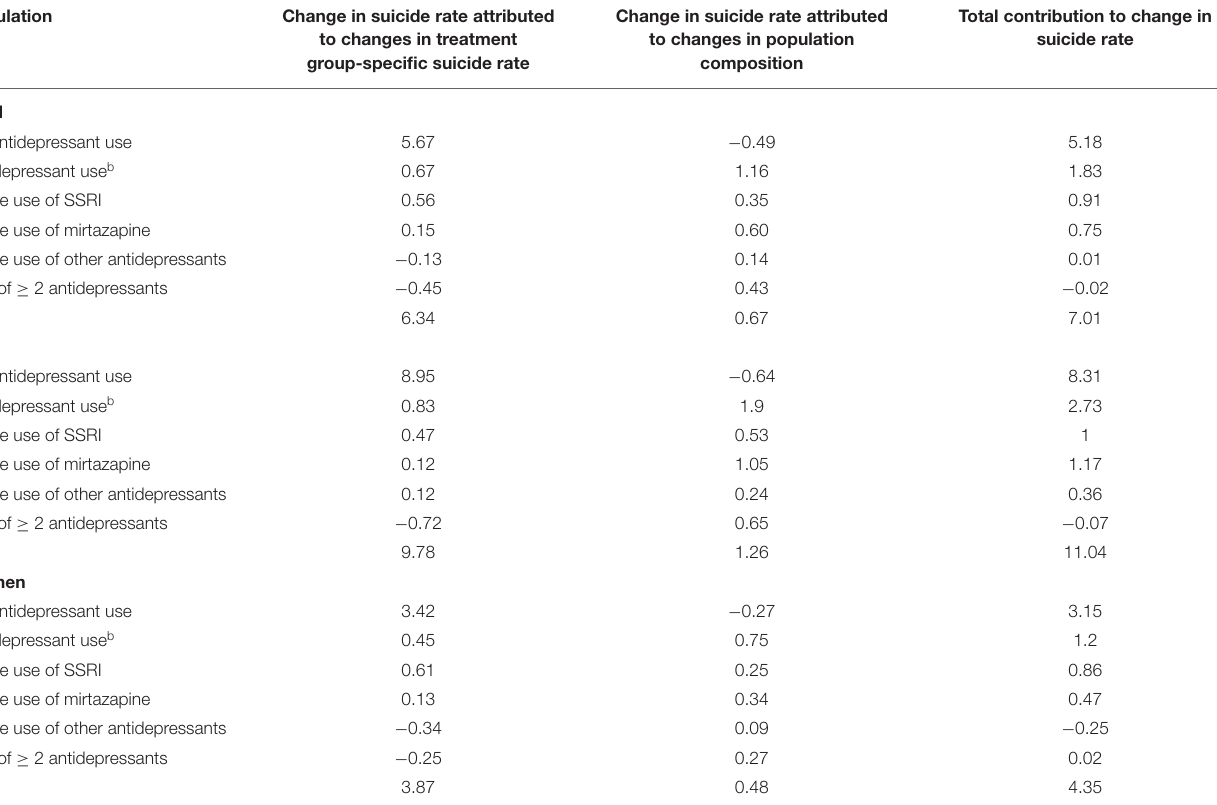
TABLE 4 | Decomposition of the change over time in the suicide rate per 100,000 by antidepressant (AD) treatment group among persons aged 75 and above residing in Sweden a from 2007–2008 to 2013–2014. Population Change in suicide rate attributed Change in suicide rate attributed Total contribution to change in to changes in treatment to changes in population suicide group-specific suicide rate composition